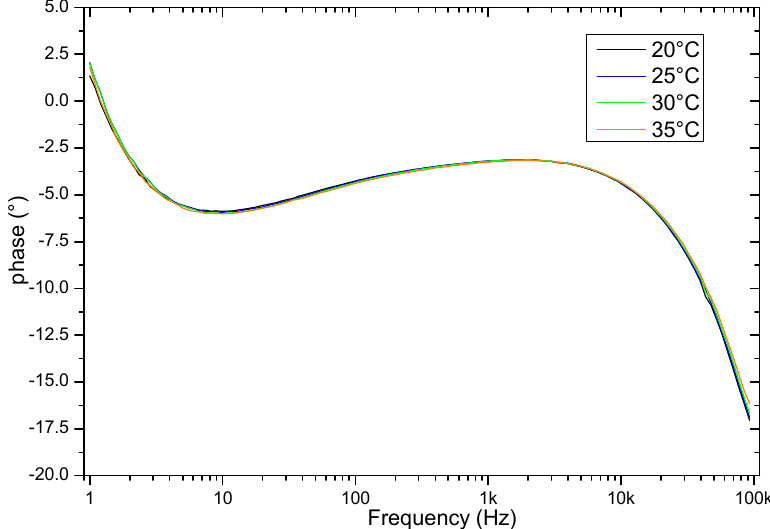
Figure 12. Phase results of the sensor response as a function of temperature.